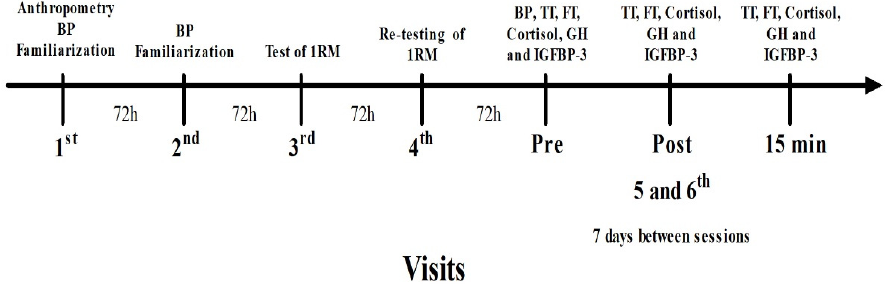
Figure 1. Study timeline. Legend: BP—blood pressure; TT—testosterone; FT—free testosterone; GH—growth hormone; IGFBP-3—insulin-like-growth-factor-1-binding-protein-3.